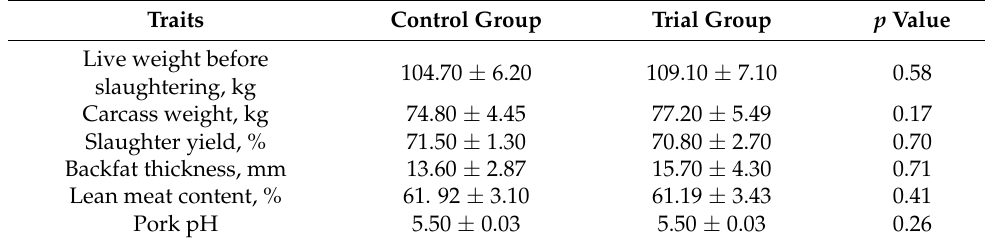
Table 4. Pig carcass